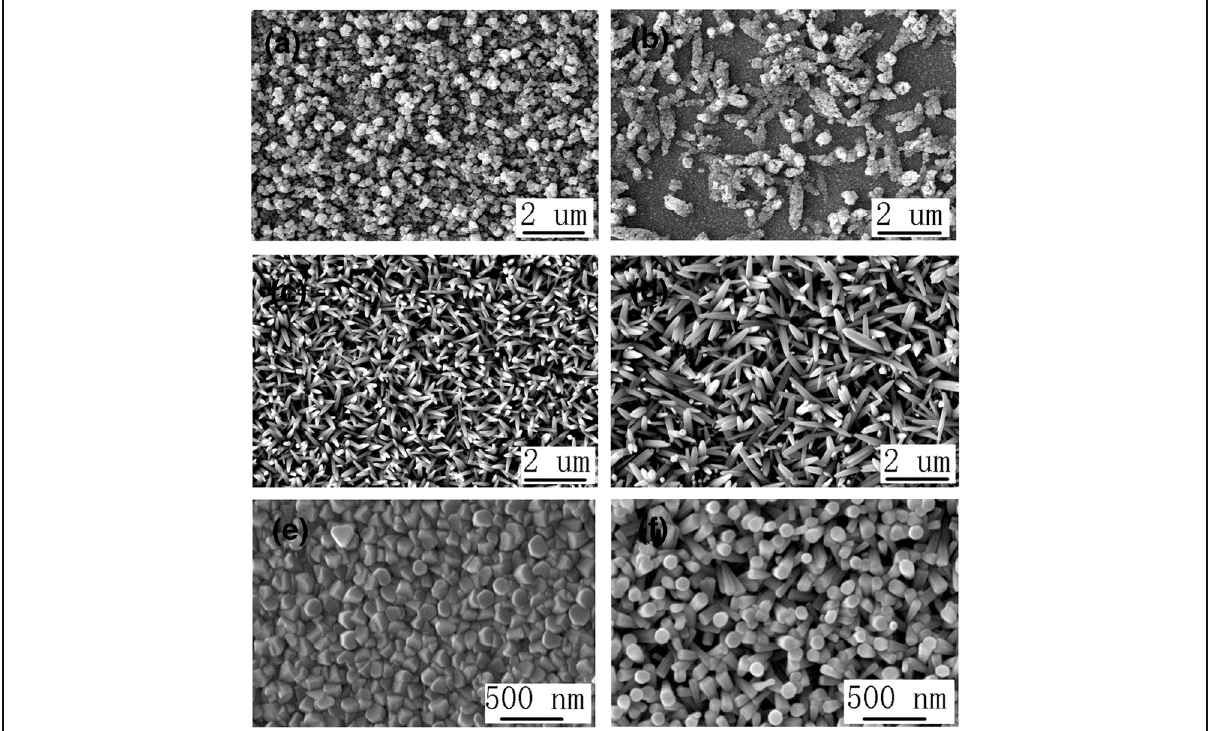
Fig. 4 The top view SEM image of ZnO/ CuSCN (3D) heterojunction ( a ), ZnO/ CuSCN (NWs) heterojunction ( b ), CuSCN (3D)/ZnO heterojunction ( c ), CuSCN (NWs)/ZnO heterojunction ( d ), CuSCN (3D) ( e ), and CuSCN (NWs) ( f